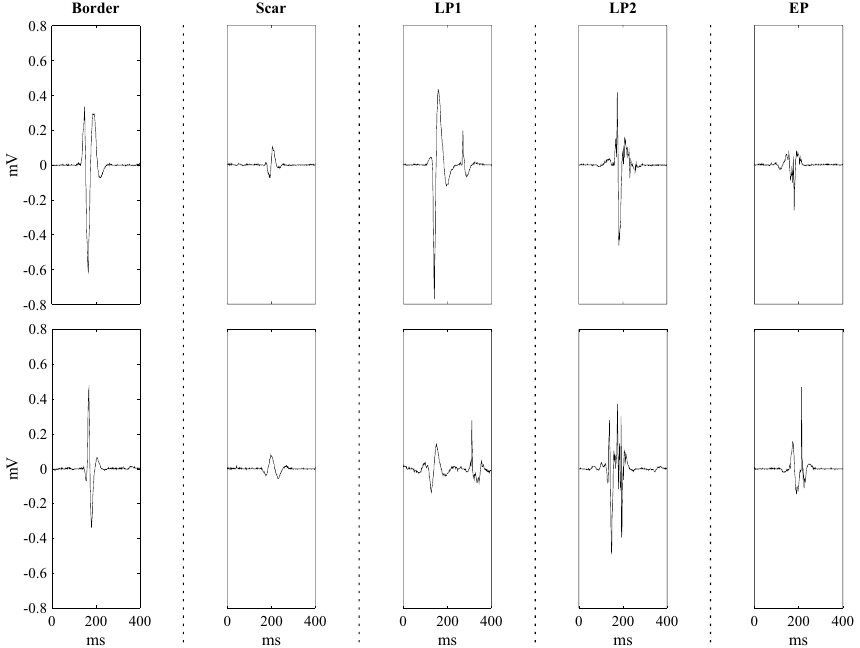
Figure 1. Prototypical examples for each EGM type. Two examples are represented on top and bottom rows for each EGM type. Specifically, from left to right, border-zone potentials, scar potentials, LP1 EGMs, LP2 EGMs and EP EGMs are